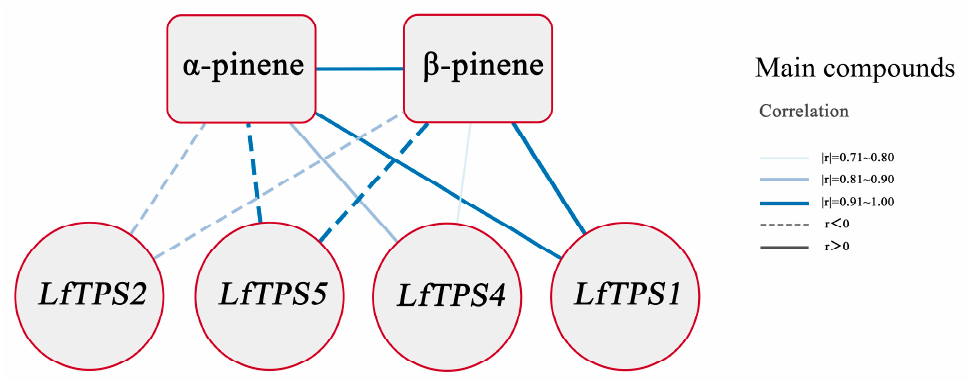
Figure 6. Interaction networks between the 4 TPSs of L. formosana , α -pinene, and β -pinene. The